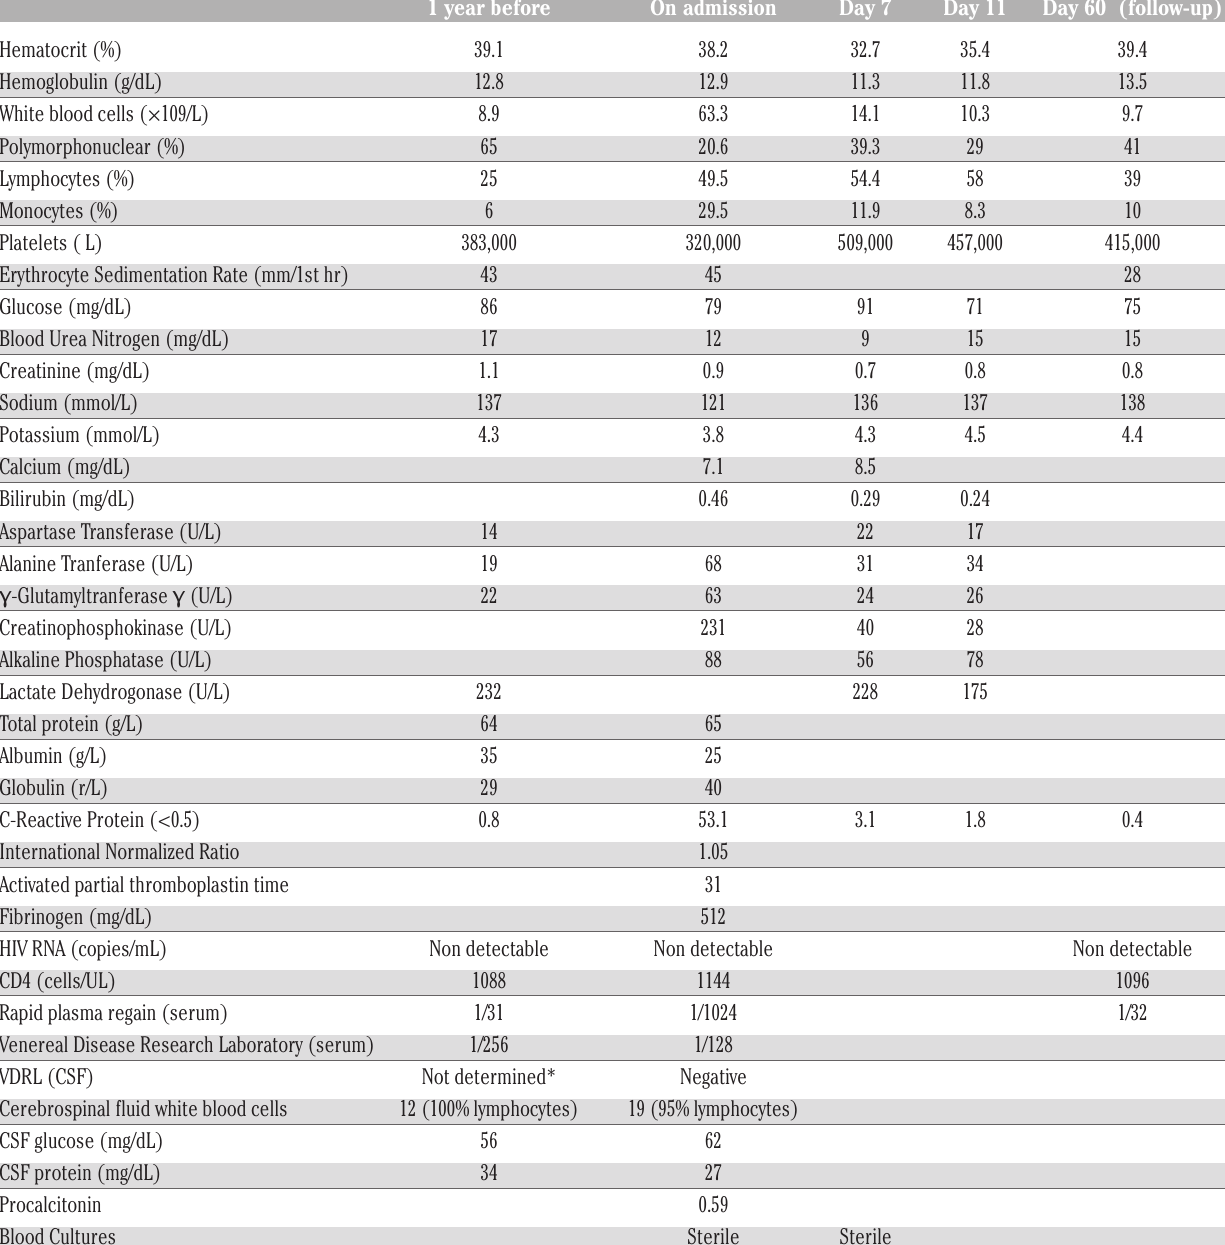
Blood Cultures Sterile Sterile *Inappropriate